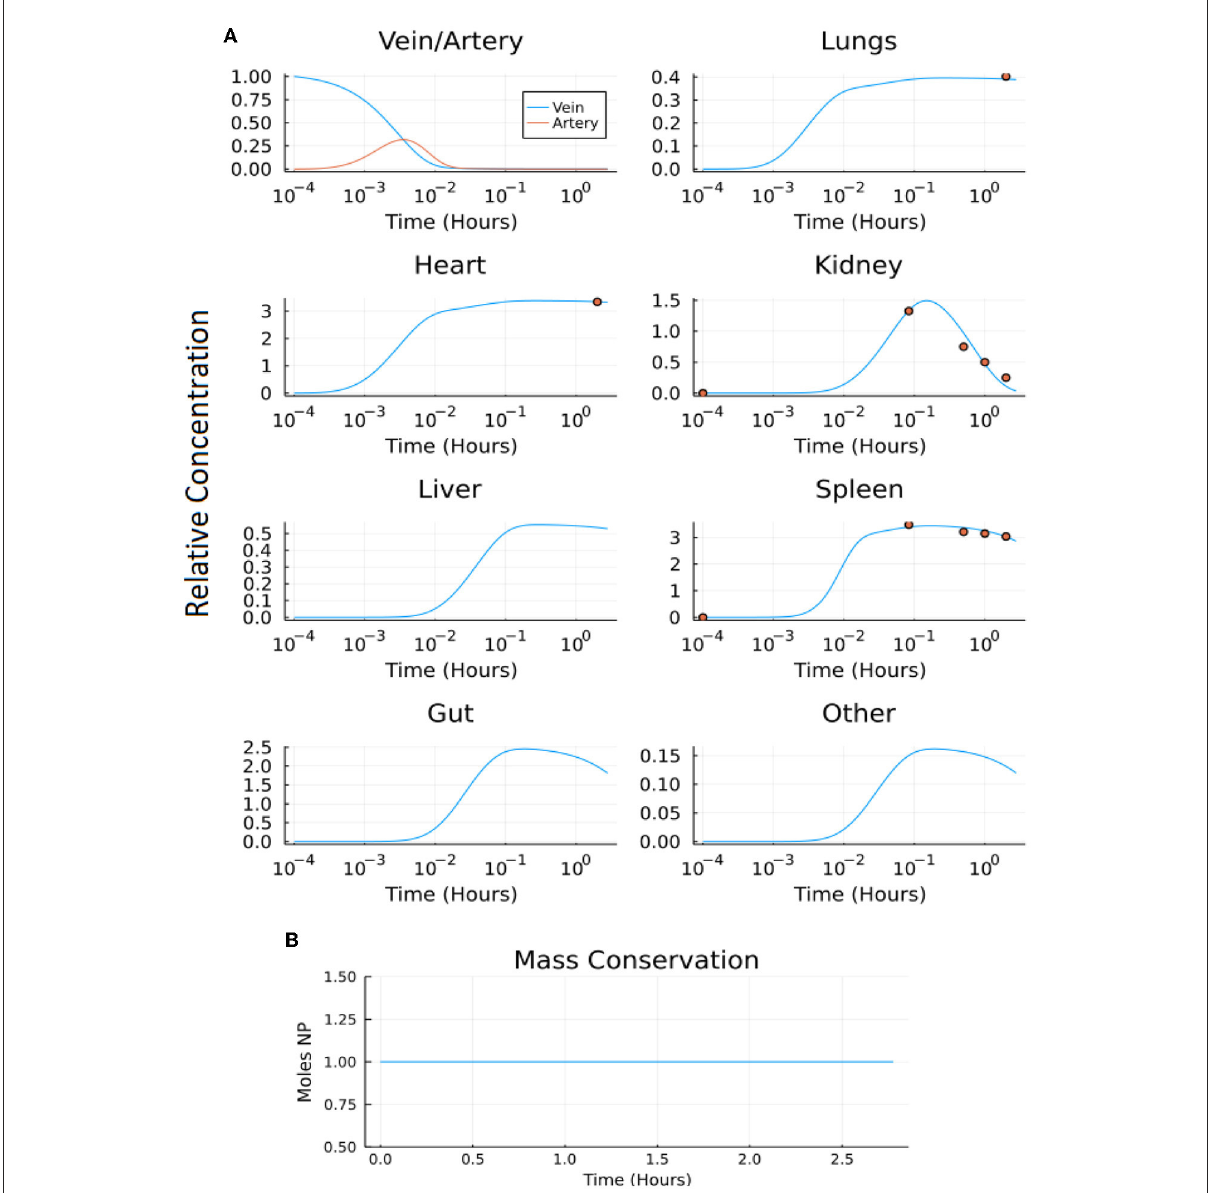
FIGURE9 Output of model B: (A) the normalized concentration of NP in each of the seven organ compartments and the arteries and veins of the model, and (B) the conservation